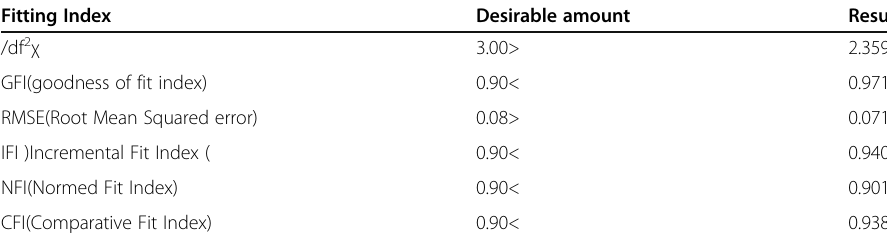
Table 7 Goodness of fit index (GFI) for the main model Fitting